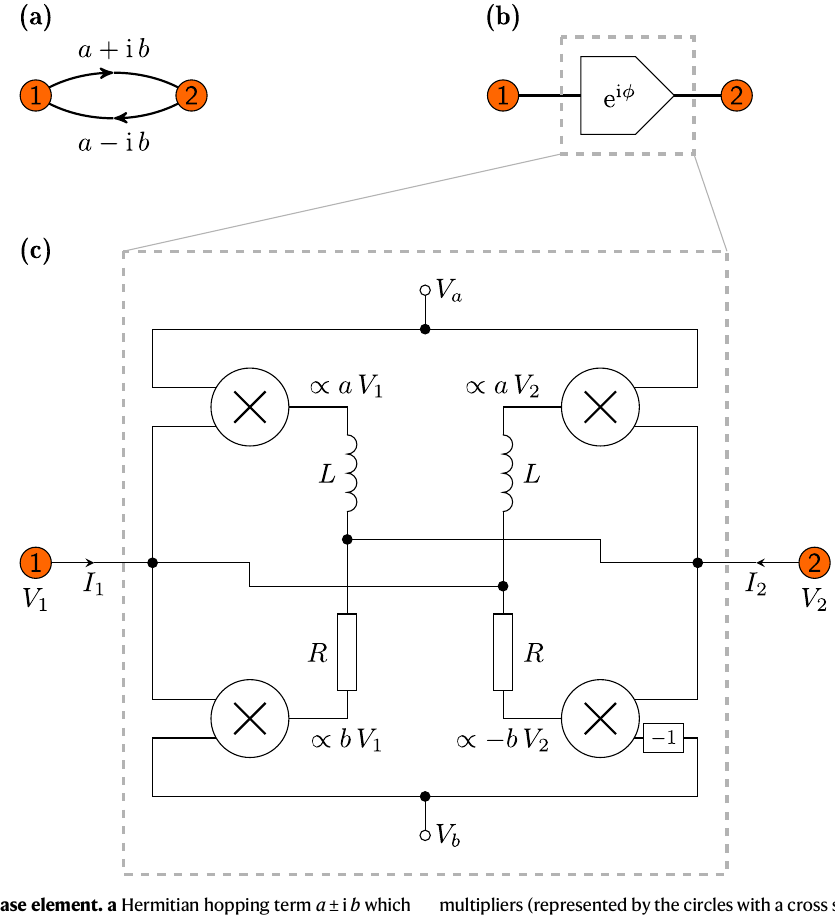
multipliers(representedbythecircleswithacrosssymbol).Wechoose R = ω L .The voltages V a and V b tune the phase ϕ = arctan V b / V a . This circuit implements the complexcouplingfromnode1to2withphase e i ϕ aswellastheback-directionfrom 2 to 1 with phase e − i ϕ